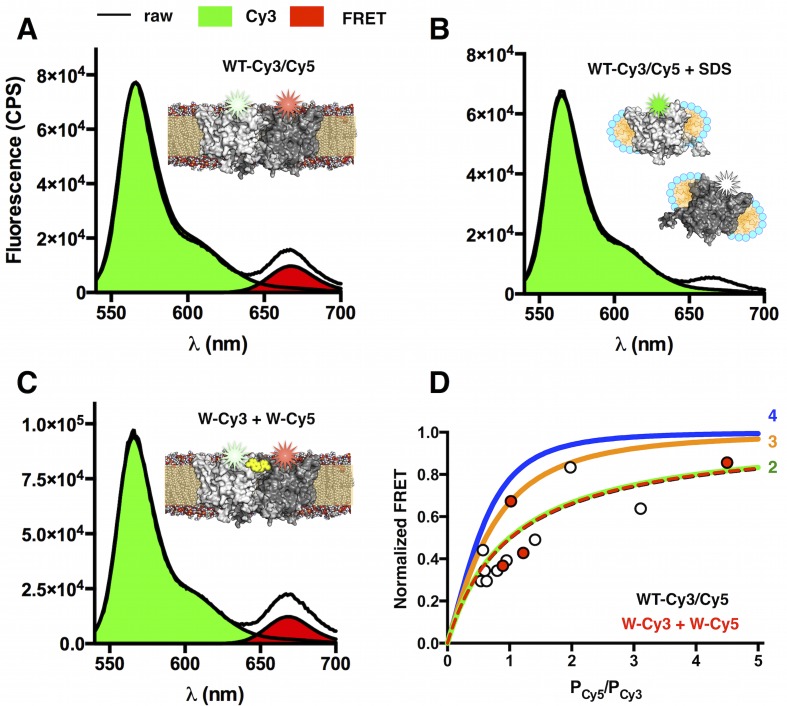
FRET measurements of WT-Cy3/Cy5 and W-Cy3 + W-Cy5 in lipid bilayers at χ = 7.5 × 10–6 subunit/lipid.(A) FRET emission spectrum (λEX = 535 nm) of co-labeled WT-Cy3/Cy5 (PCy5/PCy3= 1.2) in freeze/thawed 2:1 POPE/POPG MLVs. The raw spectrum (black) is decomposed into Cy3 donor emission (green) and FRET-specific Cy5 emission (red). (B) Addition of 0.2% SDS dissociates the dimer resulting in complete loss of the FRET signal. (C) Emission spectrum of separately labeled W-Cy3 + W-Cy5 mixed prior to reconstitution then freeze/thawed to form MLVs (PCy5/PCy3 = 1.4). (D) Saturation of FRET as a function of increasing acceptor/donor ratios fit to theoretical curves for dimer (2 - green), trimer (3 – orange) and tetramer (4 – blue) oligomeric states. WT-Cy3/Cy5 (white circles) and W-Cy3 + W-Cy5 (red circles) data are shown as symbols.